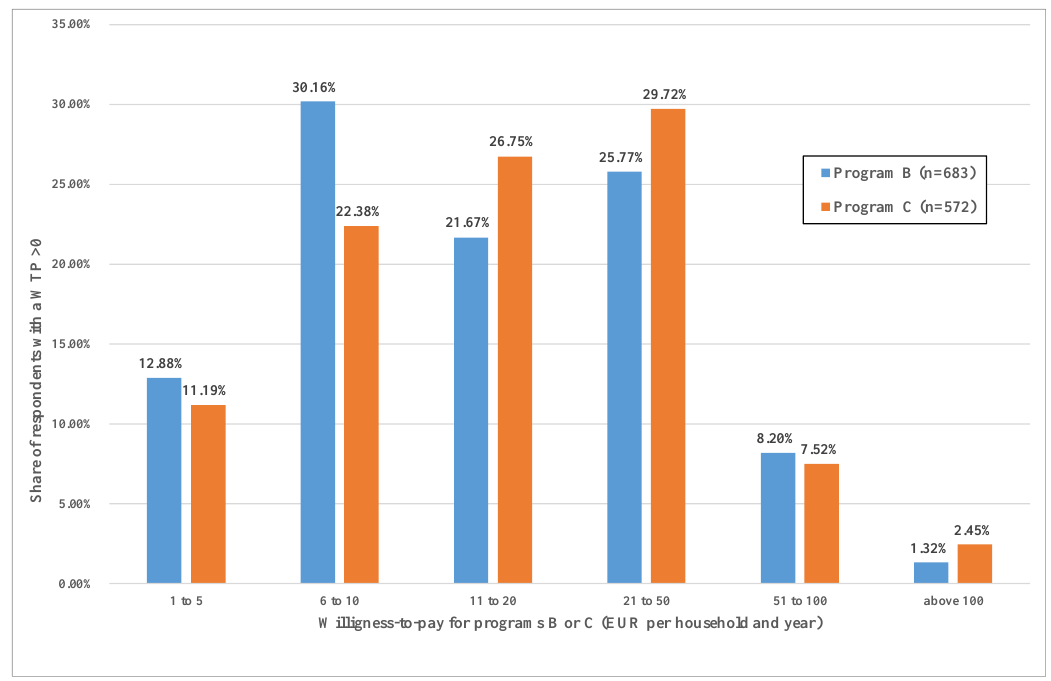
Figure 3. Distribution of the willingness to pay bids for Programs B and C.